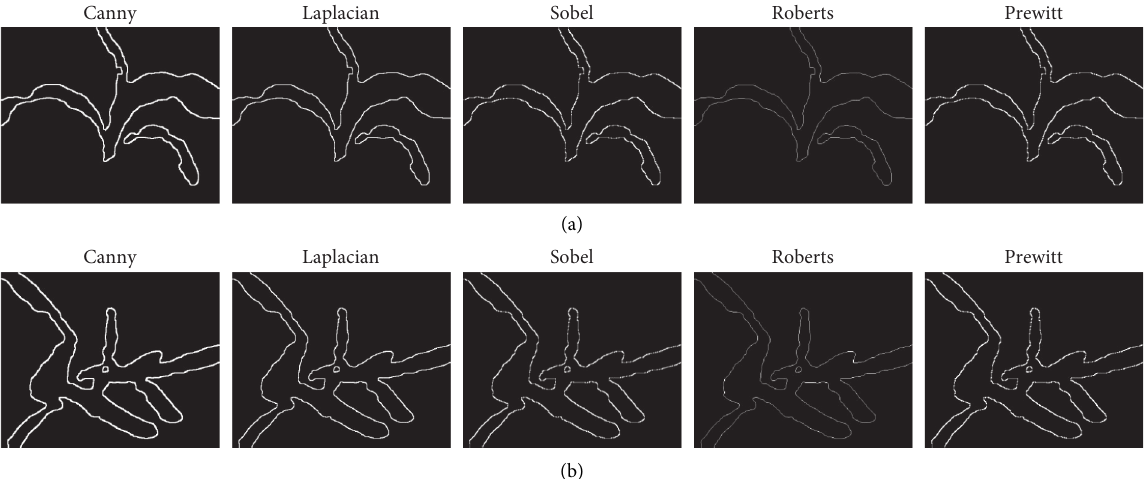
Figure 9: Experimental results of five classical edge detection operators. (a) Corn edge contour extraction image. (b) Weed edge contour extraction image.